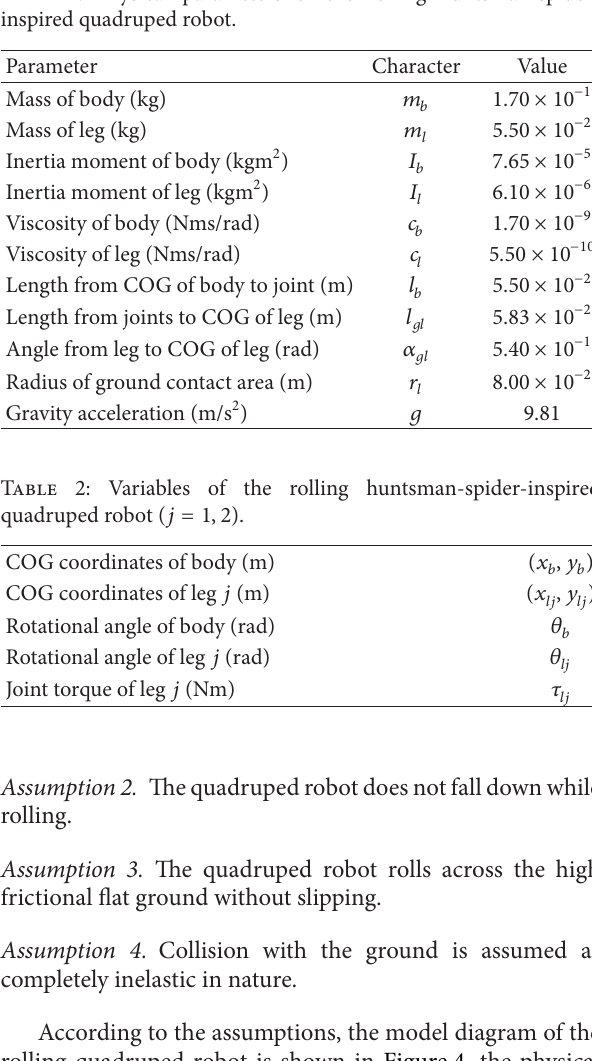
Table 1: Physical parameters of the rolling huntsman-spider- inspired quadruped robot.